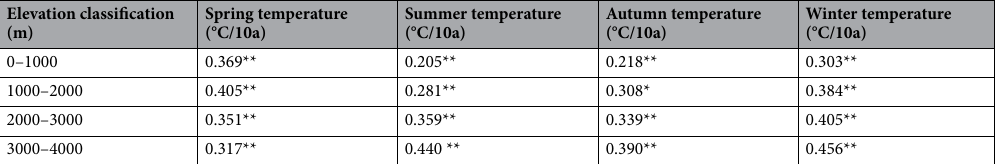
Table 2. Seasonal rate of increase in mean air temperature (°C/10a) at different elevations in the Qinling– Daba mountains during 1969–2018. * and ** indicate that the climate trends are significant at the 0.05 and 0.01 levels, respectively, based on the Mann–Kendall test for long-term